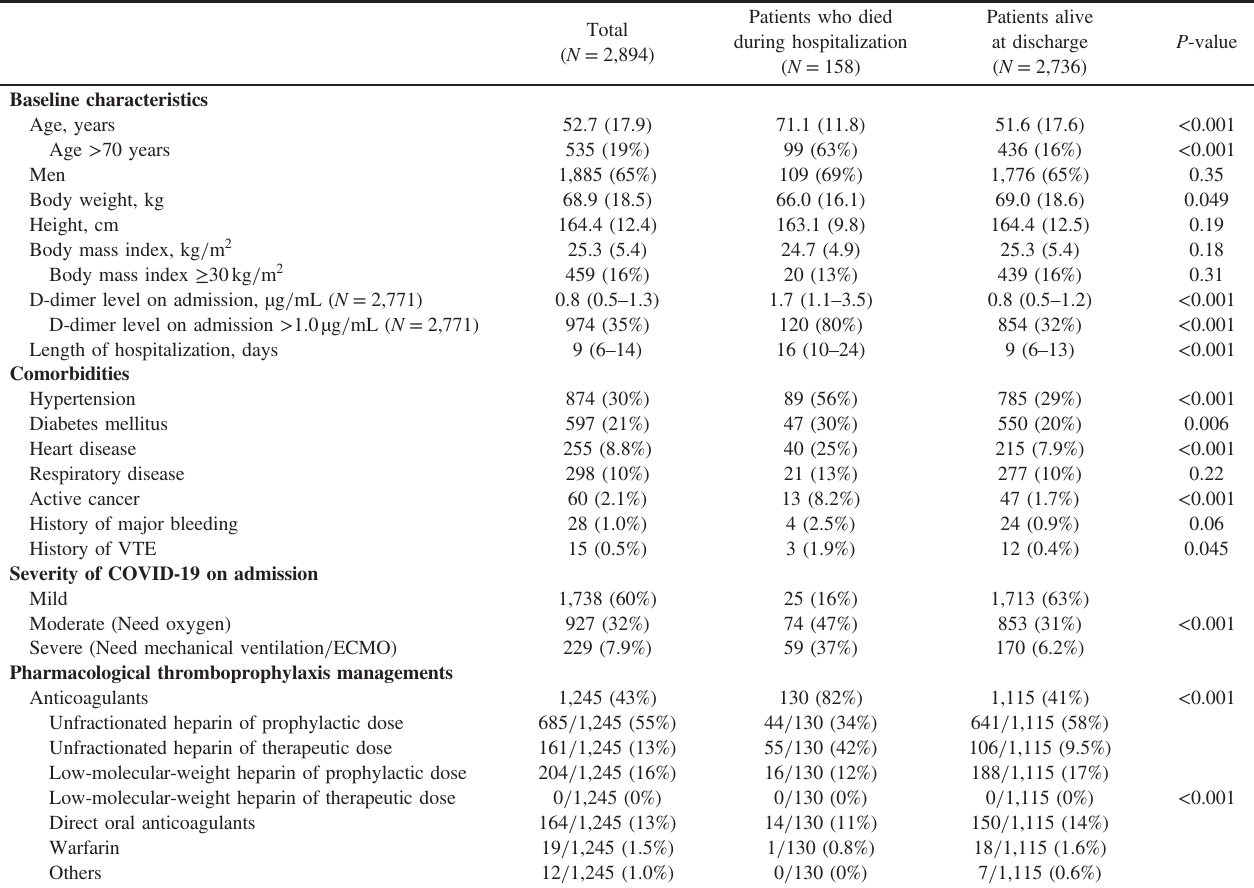
Table 1. Patient characteristics and pharmacological thromboprophylaxis managements